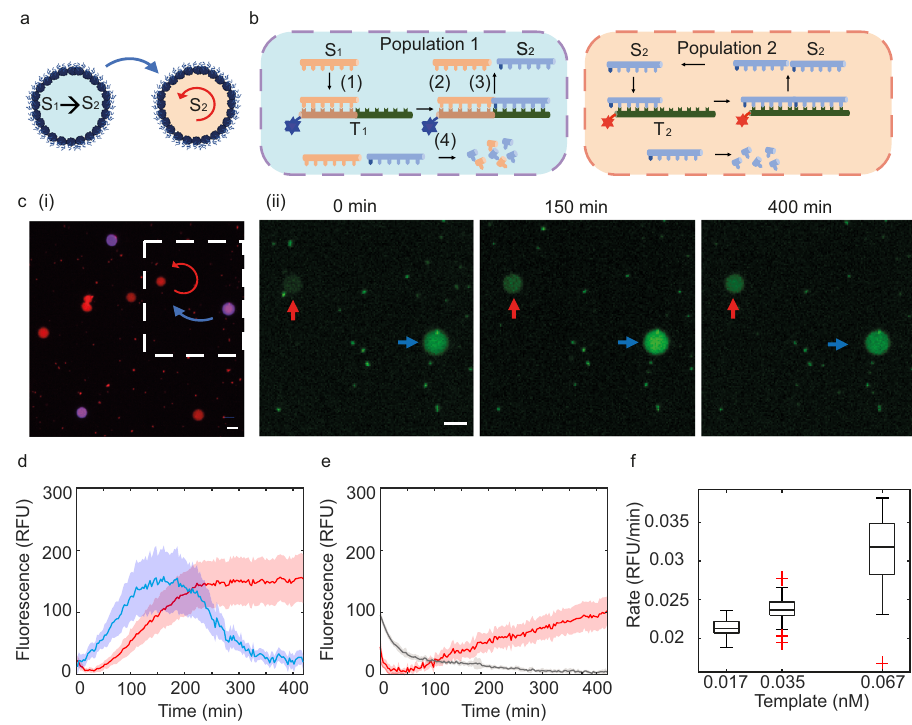
Fig. 5 Two-node networks based on encapsulated PEN DNA reactions within proteinosomes. a The product of a linear reaction programmed into population 1 activates autocatalysis in population 2. b Two different populations of proteinosomes are produced: population 1 contains ROX labelled T 1 and population 2 contains DY530 labelled T 2 . c (i) Dual-channel wide fi eld microscopy show two populations of proteinosomes. Population 1 (purple/blue) containing DNA template T 1 labelled with ROX and population 2 (red) containing DNA template T 2 labelled with DY530. (ii) Time-lapse wide fi eld fl uorescence microscopy images show increased fl uorescence intensity from non-sequence-speci fi c intercalation of Evagreen Dye due to DNA production inside the proteinosomes for populations 1 (blue arrow) and 2 (red arrow). Images are representations from two replicate experiments. Scale bar is 20 µ m. d Kinetic fl uorescence pro fi les obtained from the average kinetic pro fi les (bold line) and standard deviation (shaded region) of individual proteinosomes from populations 1 ( n = 13) (blue curve) and 2 (red) (n = 30) at a T 1 and T 2 template ratio of 1:1 (0.067 nM: 0.068 nM). e Control experiment for the two- node network population containing population 2 proteinosomes ( fi nal T 2 concentration of 0.068 nM), S 1 primer (50 nM) and in the absence of T 1 proteinsomes. The bold red curve is obtained from the average kinetic pro fi les of T 2 proteinosomes ( n = 8). The grey curve is obtained from the average kinetics of the background (9 circular regions with diameter of 20 pixels in the background ( n = 9)). The shaded colours in the plots in a-c are the standard deviations from the kinetic curves from individual proteinosomes in their corresponding populations. f Reaction kinetics of a two-node network cell population. Box plot showing the initial rates of the autocatalytic reaction (population 2) as a function of template concentration (T 1 ) for 0.017 nM ( n = 23), 0.035 nM ( n = 29) and 0.067 nM ( n = 30). The central line and yellow open circle represent the median line and the fi rst and third quartile, error bars represent the upper and lower adjacent values and the blue data points are the outside points. Source data are provided in the source data fi